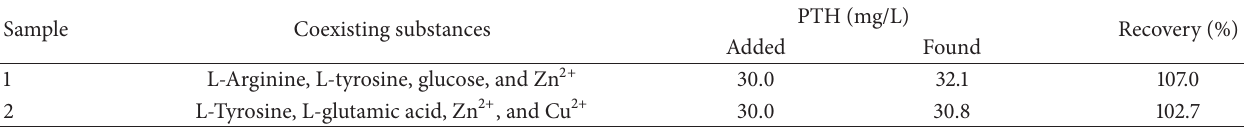
Table 2: Results of the determination of PTH in synthetic samples ( 𝑛 = 5 ).